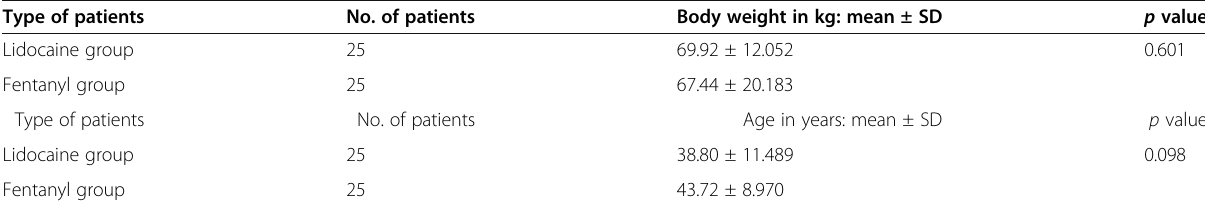
Table 1 Patient ’ s